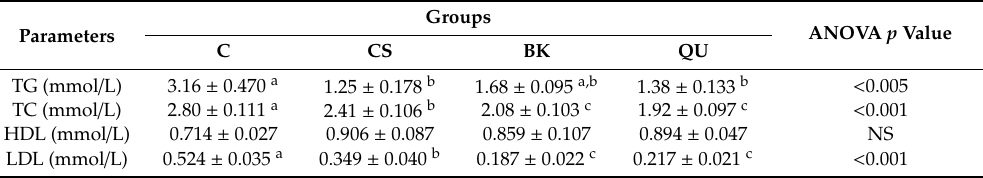
Table 5. Plasma lipid profile in rats fed experimental